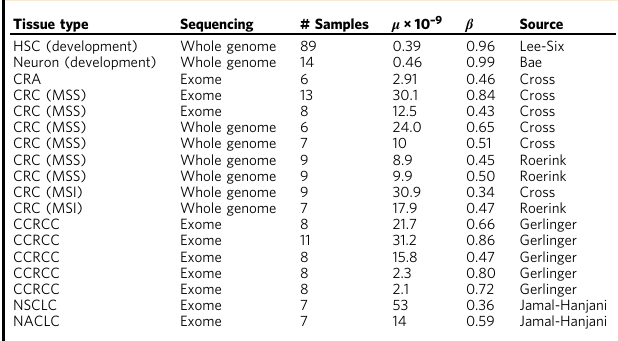
Table 1 Data summary and evolutionary parameter